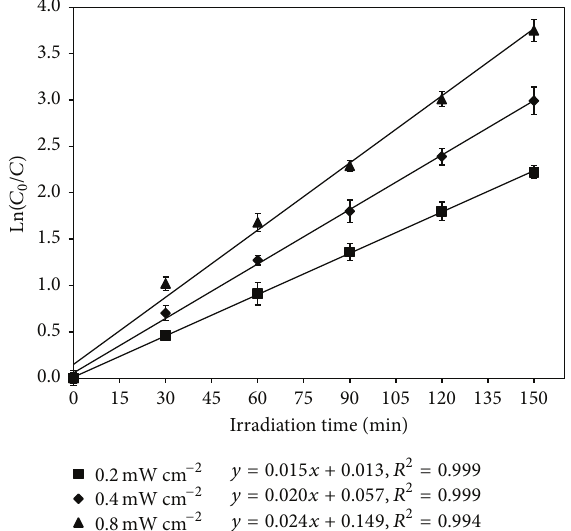
Figure 6: Efficiency of photocatalytic degradation of MC-LR as a function of light intensity. (Experimental conditions: MC-LR con- centration of 1mg L −1 and Pt/WO 3 concentration of 100mg L −1